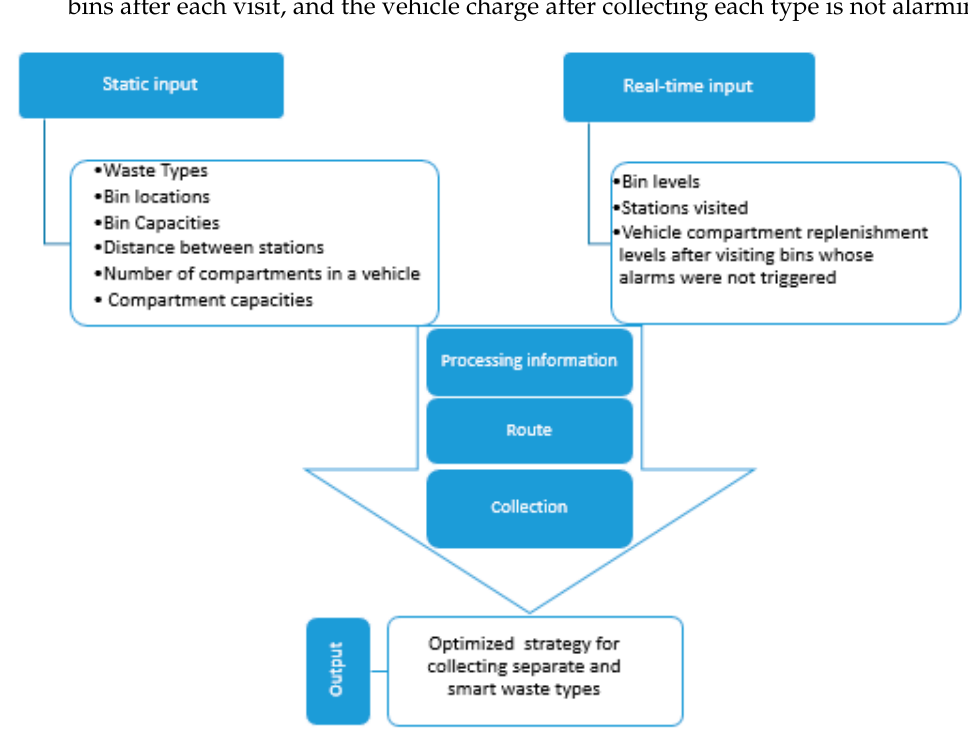
Figure 4. Real time data routing model for separate waste collection.